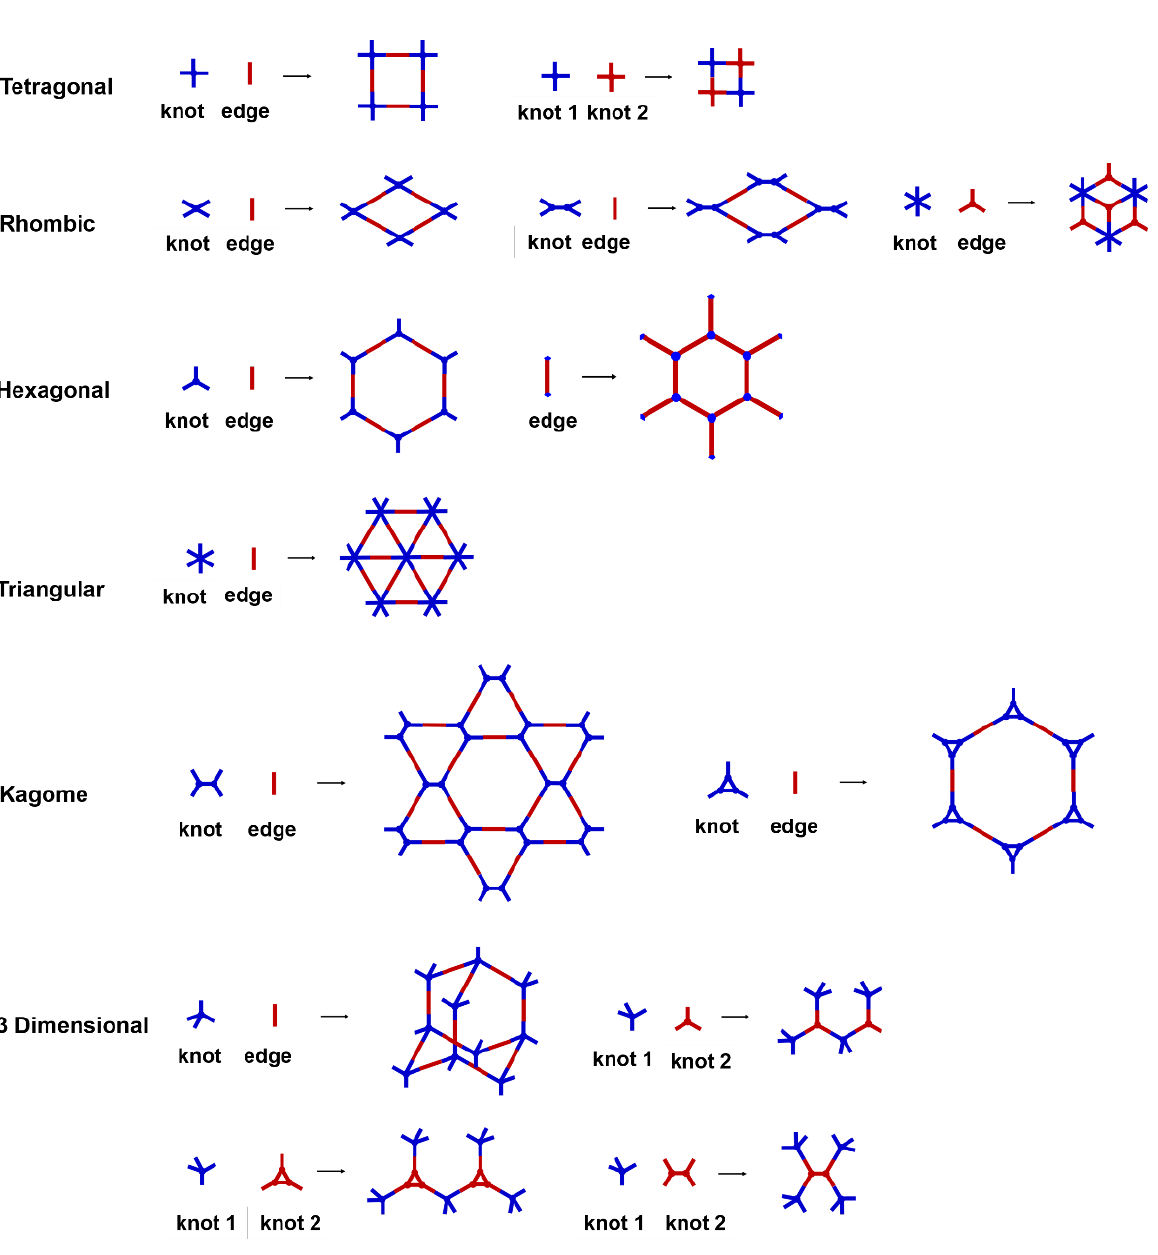
Figure 1. The basic topology of the COFs. Table 1. The dynamic linkages for COF synthesis.